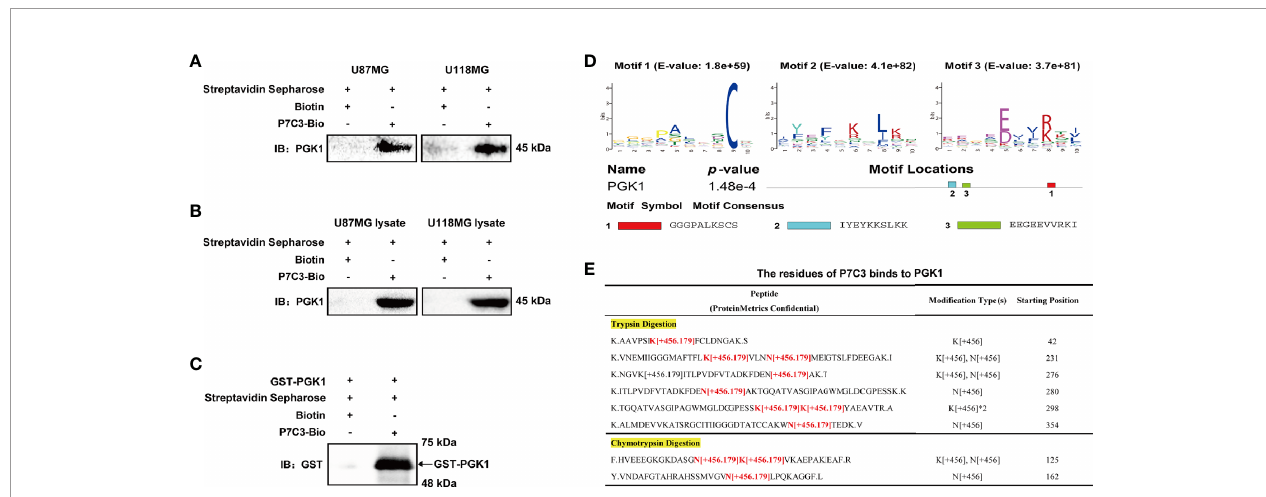
FIGURE 4 | P7C3 directly binds to PGK1. (A) Streptavidin af fi nity assay for P7C3-Bio binds to PGK1 in P7C3-treated glioma cells. Cells in culture were treated with 50 m M P7C3-Bio for 24 h, and then streptavidin agarose was added to incubate with the cell lysates. (B) Streptavidin af fi nity assay for P7C3-Bio binds to PGK1 upon cell lysates. Cell lysates were incubated with 10 m M P7C3-Bio at 37°C for 1 h, and then streptavidin agarose was added to incubate with the cell lysates. (C) Streptavidin af fi nity assay for P7C3-Bio binds to puri fi ed PGK1 protein. In total, 25 m g recombinant human PGK1 solution was incubated with 10 m M P7C3-Bio at 37°C for 1 h, and then streptavidin agarose was added to incubate with the cell lysates. (D) Motif analysis based on top 100 P7C3 target proteins was performed by MEME, and three motifs were identi fi ed. The motif consensus and motif locations at PGK1 are shown. (E) The P7C3 binding sites of PGK1 were identi fi ed by ESI-LC-MSMS. The P7C3 binding sites were identi fi ed by the predicted peptide mass plus P7C3 [C 21 H 18 Br 2 N 2 O with a loss of a water] and minus one